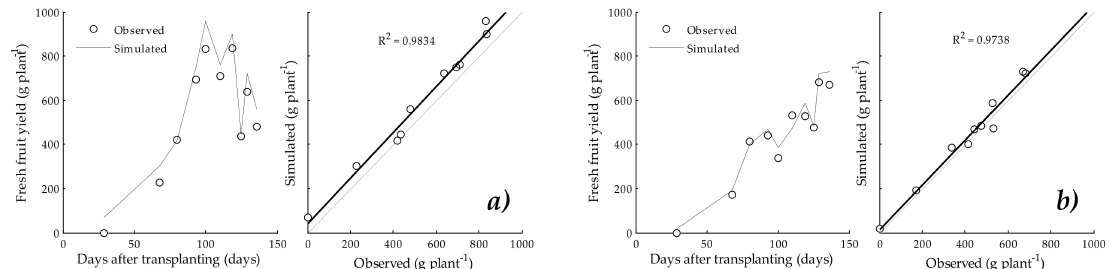
Figure 4. Fresh fruit yield of tomato plants grown in the ( a ) substrate and ( b )